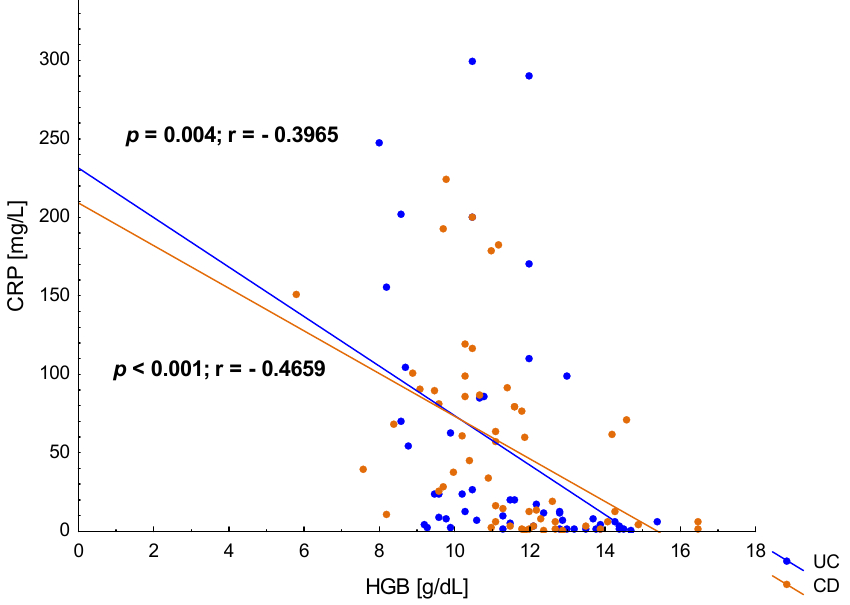
Figure 5. The correlation between C-reactive protein (CRP) and haemoglobin (HGB) concentration in patients with ulcerative colitis (UC) and Crohn’s disease (CD).